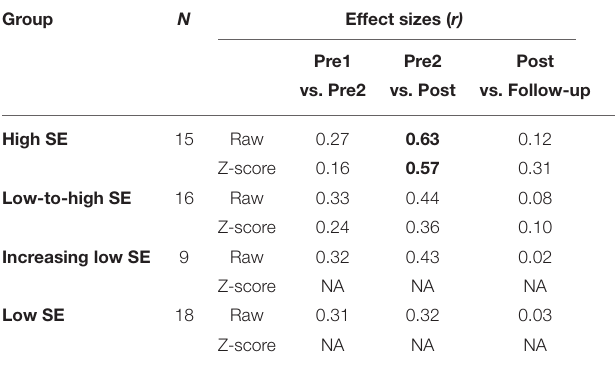
TABLE 7 | Effect sizes for changes in calculation fluency